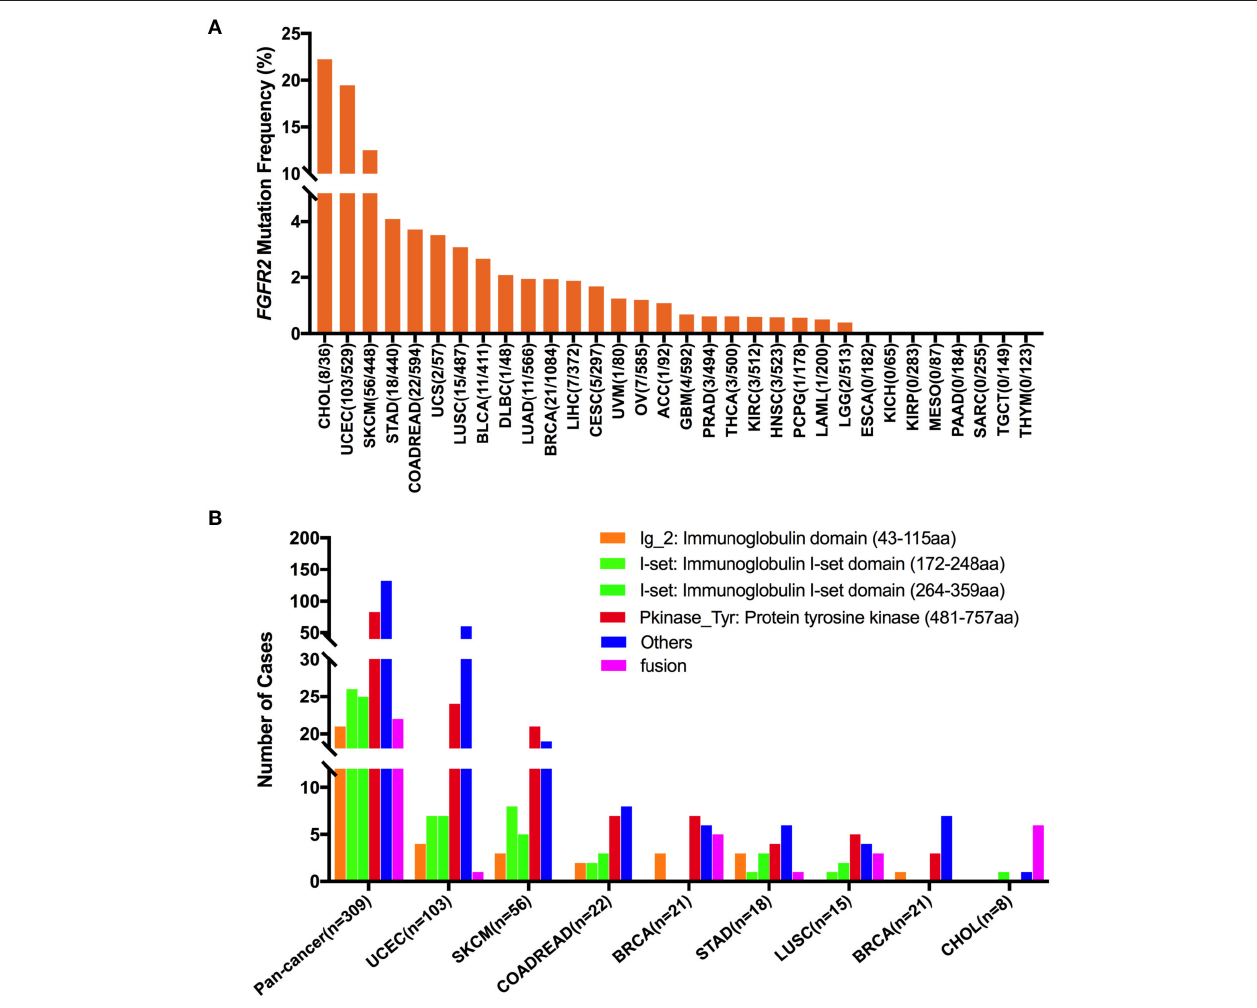
FIGURE 3 | FGFR2 mutation distribution in 32 TCGA provisional cancer types and protein functional domains. (A) FGFR2 mutation frequency across different cancer types. (B) FGFR2 mutation distribution in different functional domains in all cancer types and in the top 8 cancer